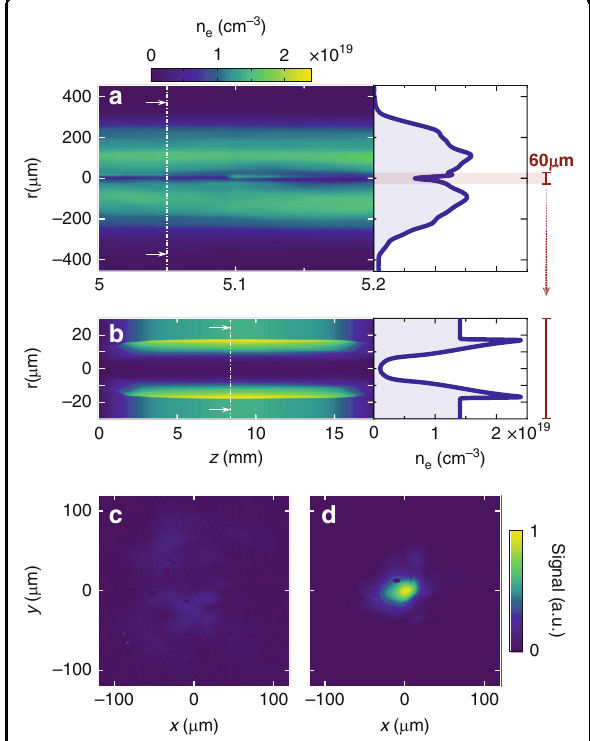
Fig. 2 Plasma channel and guiding. a Measured density pro fi le. The density in the middle of the waveguide is overestimated because of limited resolution. b Simulated plasma channel (see Methods). c , d , Laser focal spot of P1, measured after attenuation of the full energy beam at the exit of the plasma, without ( c ) and with ( d )